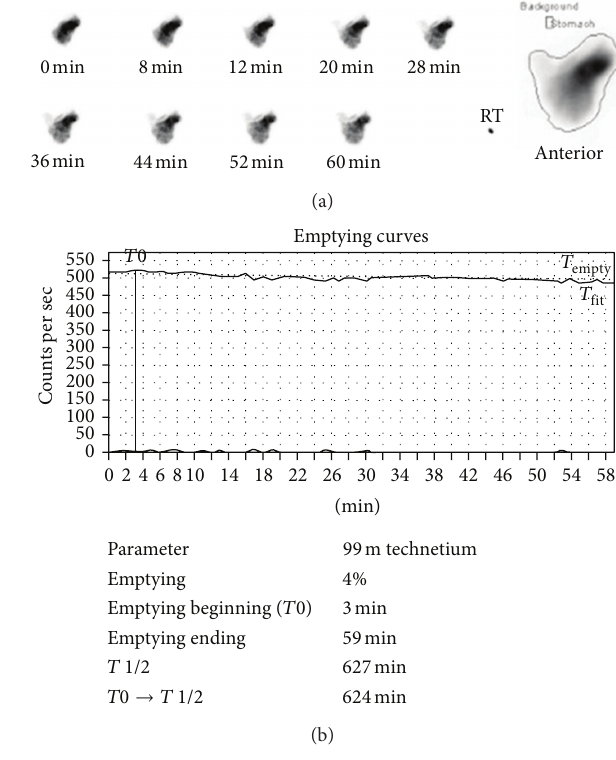
Figure 4: Gastric emptying study for patient IS following laparo- scopic left hepatectomy. (a) Gastric emptying was observed for 60 minutes with intermittent imaging. The region of interest is indicated at right by a line drawn around the activity within the stomach in the anterior view. (b) The emptying curves over 60 —solid; 𝑇 —dotted) are shown. The half-emptying minutes ( 𝑇 empty fit time ( 𝑇 1/2) was calculated using the geometric mean. Gastric emptying time was markedly delayed, with no definitive evidence of radiotracer passing into the duodenum during the 60-minute period.